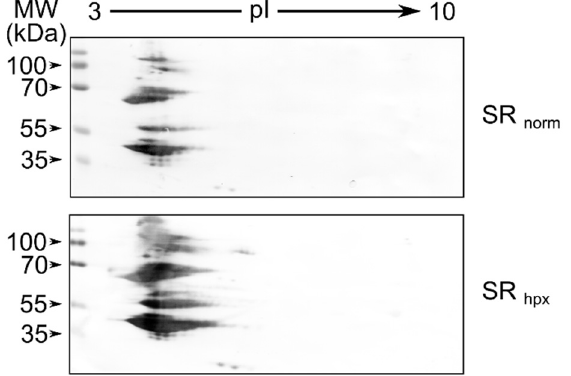
Figure 9. Hypoxia induces modifications of SR proteins. Western blot of two-dimensional gel electrophoresis of SR proteins isolated from HCT116 cells cultivated under normoxic (SR norm) and hypoxic (SR hpx) conditions for 4 h.